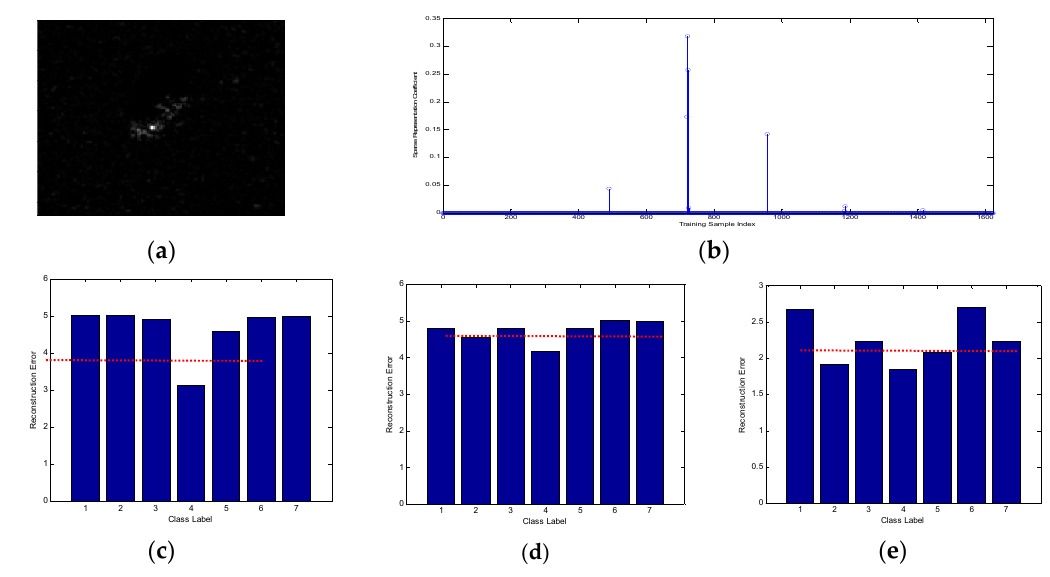
Figure 9. ( a ) Test sample BTR70-C71; ( b ) Sparse vector obtained based on ADNNLS algorithm; ( c ) Reconstruction error of ADNNLS algorithm; ( d ) Reconstruction error of SRC algorithm; ( e ) Reconstruction error of NNLS algorithm.